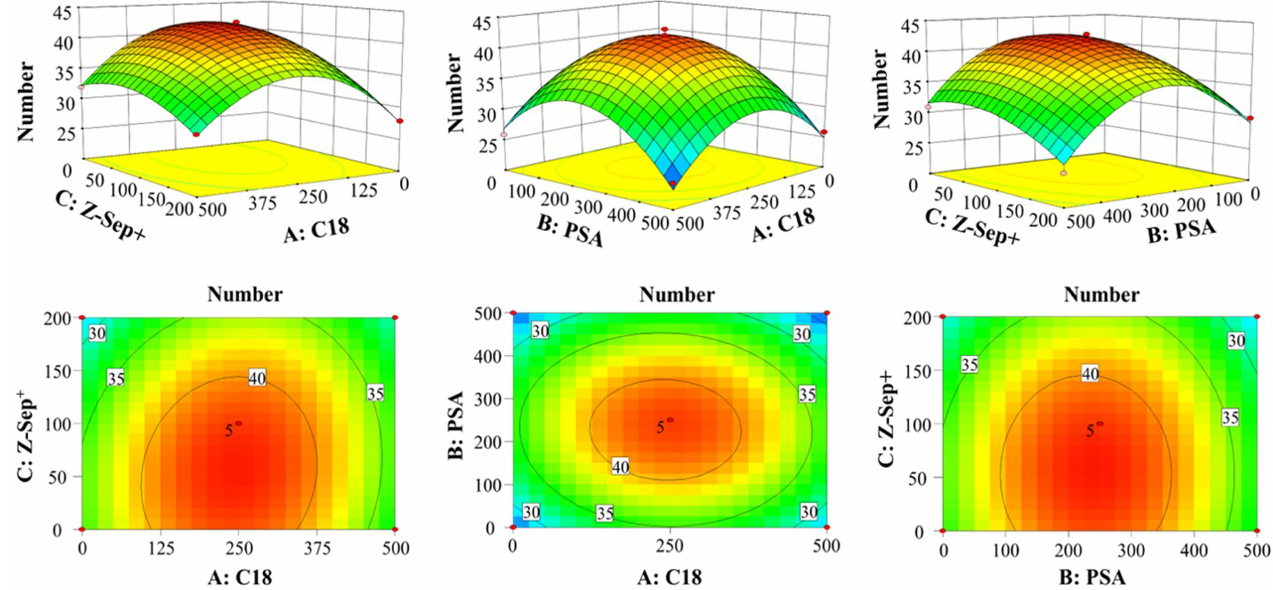
Figure 3. Response surface map for the interaction of various factors.